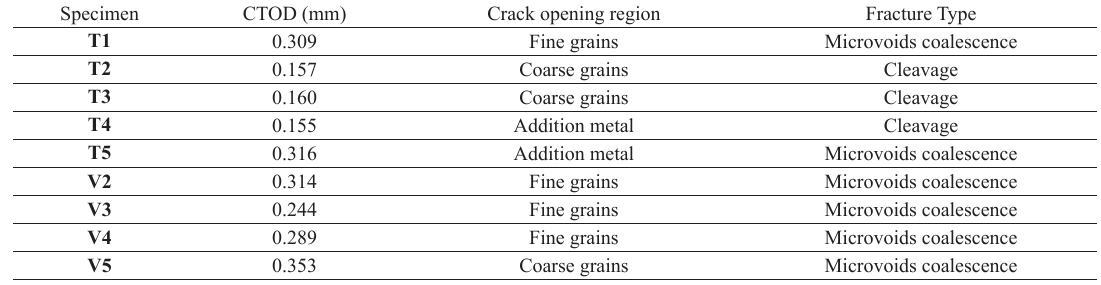
Table 8. Relationship between CTOD value, microstructure and fracture type after residual stress relief.